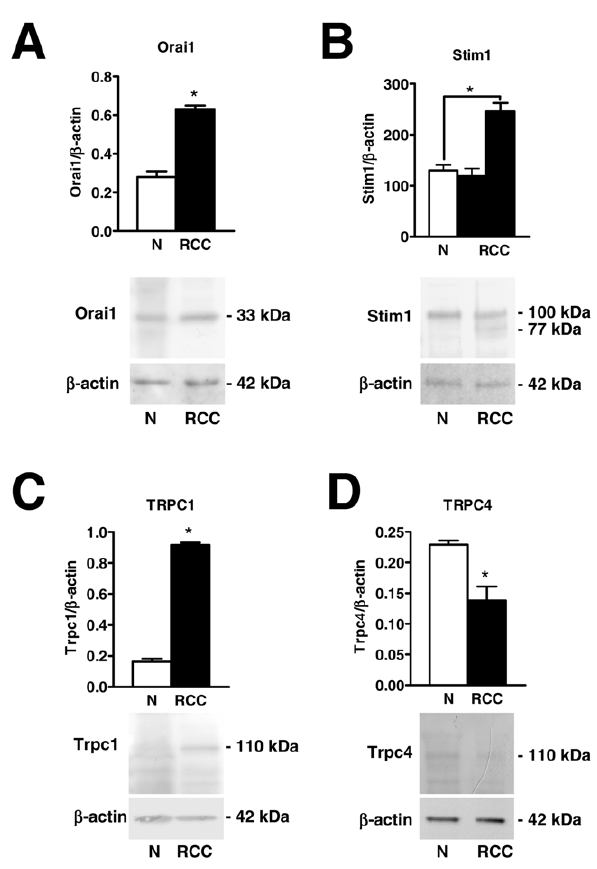
Figure 4. Orai1, Stim1, and TRPC1 proteins are over-expressed in endothelial progenitor cells isolated from patients suffering from renal cellular carcinoma. Western blot and densitometry depicting the significant elevation in Orai1 (A), Stim1 (B), and TRPC1 (C) proteins in RCC-EPCs as compared to N-EPCs. Conversely, TRPC4 protein (D) is down-regulated in RCC-EPCs. Blots for Orai1, Stim1, TRPC1 and TRPC4 representative of 4 different experiments are shown in the lower panel. Lanes were loaded with 20 m g of proteins. Major bands of the expected molecular weight were observed in both cell types. One additional band of 77 kDa was detected by anti-Stim1 in RCC-EPCs. When both Stim1 bands (77 and 100 kDa) were compared to the single band detected at 100 kDa in N-ECFCs, the expression of Stim1 protein became significantly higher in RCC-EPCs (see text for further explanations). Each bar in the upper panel represents the mean 6 SE of the densitometric analysis of four different experiments. The asterisk indicates p , 0.01 (Student’s t